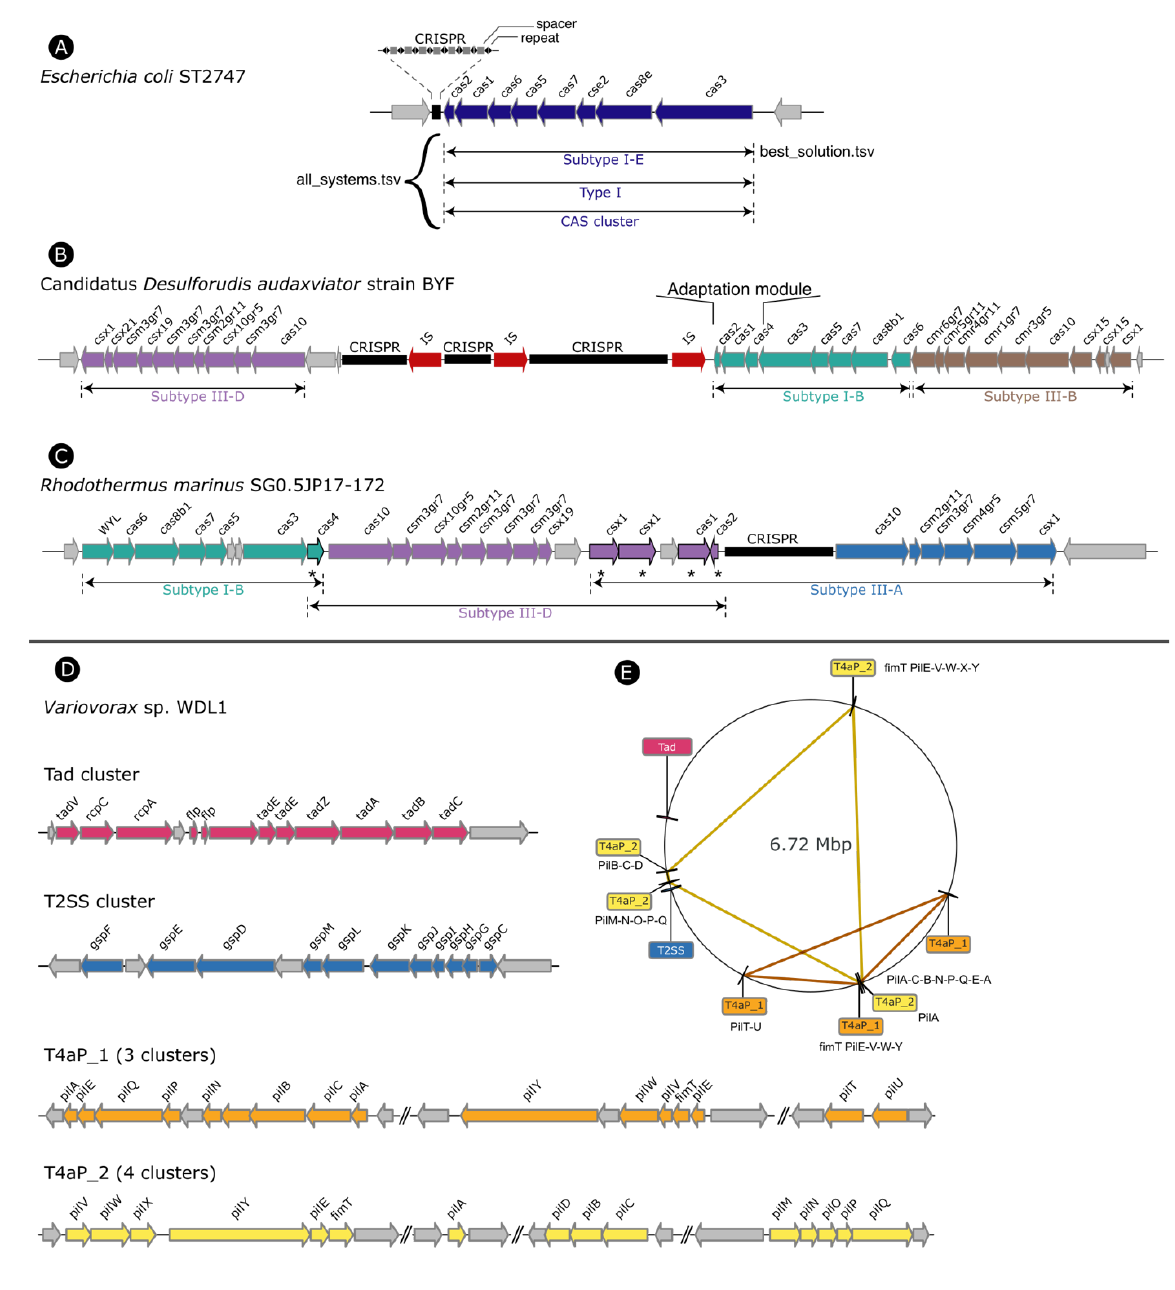
Figure 6 - Application of MacSyFinder v2 to CasFinder (v3.1.0) and TFFscan (v1.0.0). (A) CRISPR-Cas system has two parts: a CRISPR array and a cluster of cas genes. The new MacSyFinder search engine simultaneously annotates Cas clusters at 3 levels of classification from the most accurate (i.e. the subtype level) to the most permissive. When possible, it favours as the best solution the annotation at the subtype level but allows to recover atypical or decayed systems with the 2 other levels of classification. (B) The combinatorial approach for the search of the best solution improves the detection of tandem systems. All models are tested and challenged, then the best combination of systems is determined. Here, it reveals the presence of 3 systems of different subtype in tandem (one color per subtype). (C) The new search engine avoids overlap between different candidate systems to determine the best solution(s), unless specified in the model with the multi_system or multi_model features. As illustrated, the adaptation module (cas1, cas2 and cas4) has been defined as “multi_model” (indicated by a star*) in some subtype models and can thus be assigned to 2 systems in tandem, which improves their identification. Without this feature newly implemented in v2, one of the two systems would be lost. (D) Several members of the Type IV filament super-family (TFF-SF) could be found in the genome of Variovorax sp. WDL1. The new search engine enables the annotation of two distinct T4aP in the same genome. Here we can observe that the two detected T4aP are gathering clusters of different and complementary gene composition, underlying their coherence.